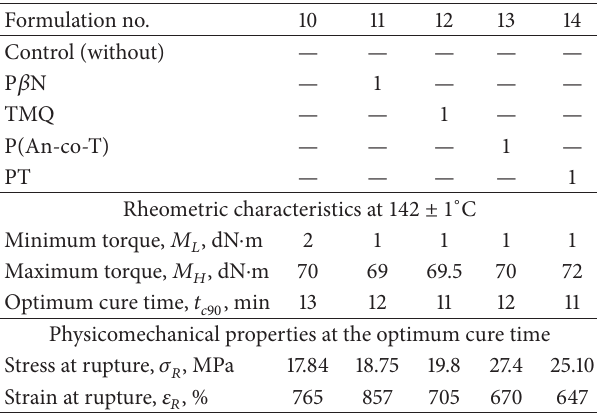
Figure 6: Retained equilibrium swelling versus ageing time for SBR vulcanizates. Table 5: NR formulations containing the prepared P(An-co-T) and PT.